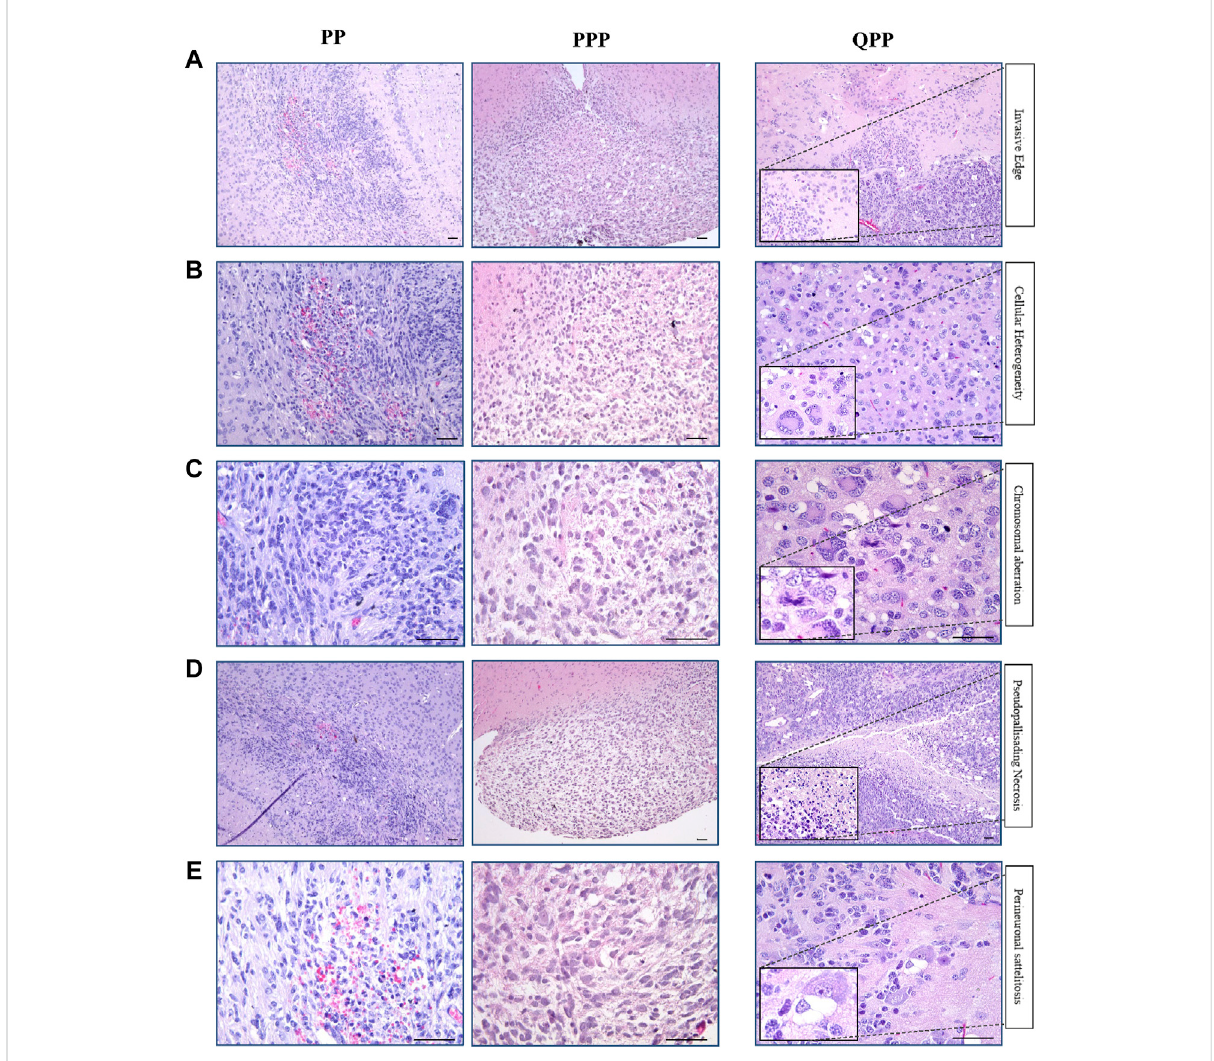
FIGURE 3 Histopathological analyses identi fi ed the brain tumor isolated from the PPP cohort as low-grade glioma. (A) . Representative H&E images of tumorsharvestedfromQPP,PPP,andPPcohortsdemonstratinginvasiveedges. (B) .RepresentativeH&EimagesoftumorsharvestedfromQPP,PPP, and PP cohorts indicating intra-tumor cellular heterogeneity. (C) . H&E images of tumors harvested from QPP, PPP, and PP cohorts representative of chromosomalaberrations. (D) .RepresentativeH&EimagesoftumorsharvestedfromQPP,PPP,andPPcohortsdisplayingintra-tumornecrosis. (E) . Representative H&E images of tumors harvested from QPP, PPP, and PP cohorts exemplifying perineuronal satellitosis. Scale bars represent 50 μ